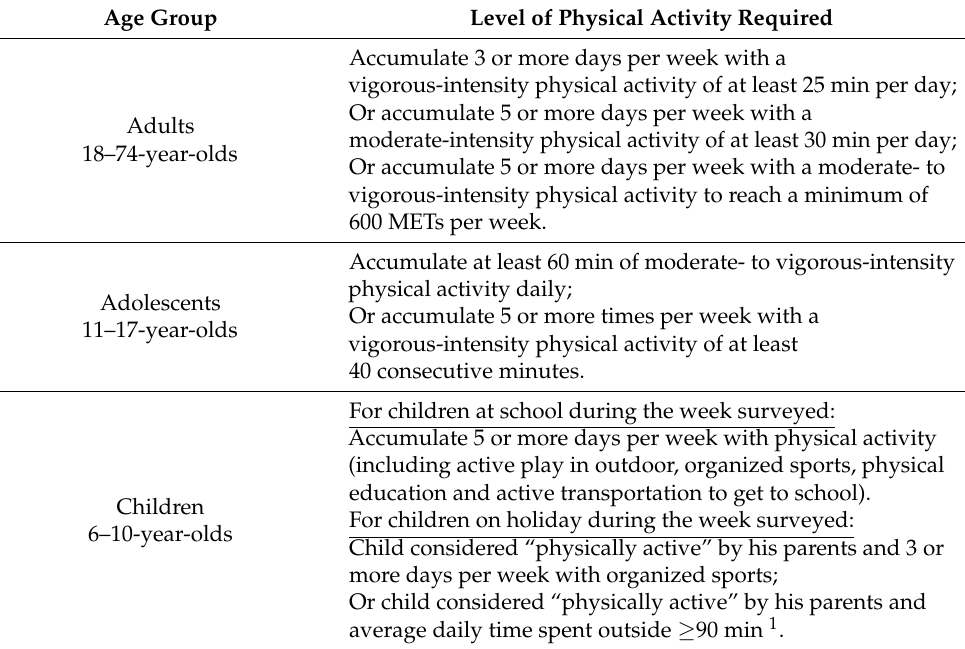
Table 1. Level of physical activity required to meet health recommendations for adults and